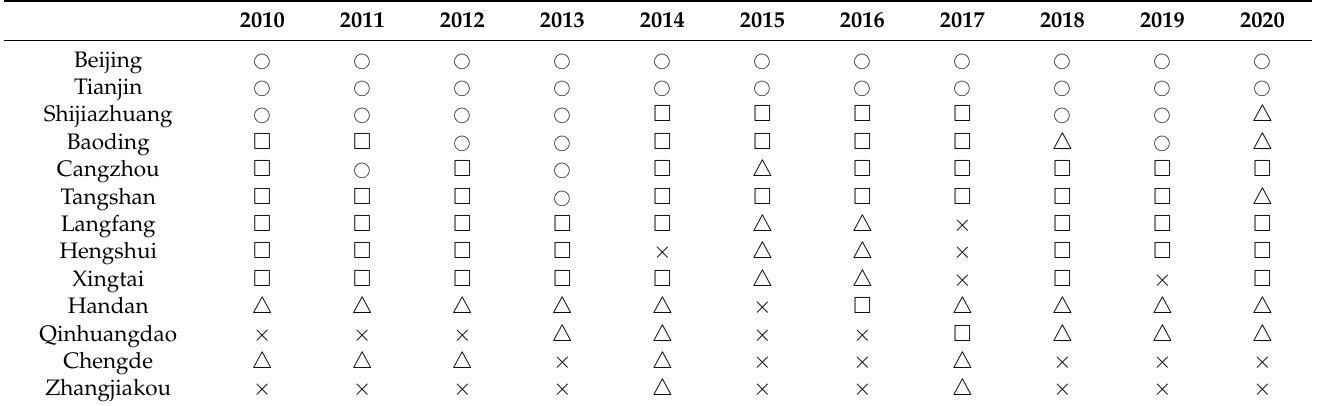
Table 6. Results of the block model of a housing prices’ association network in the BTHUA from 2010 to 2020.